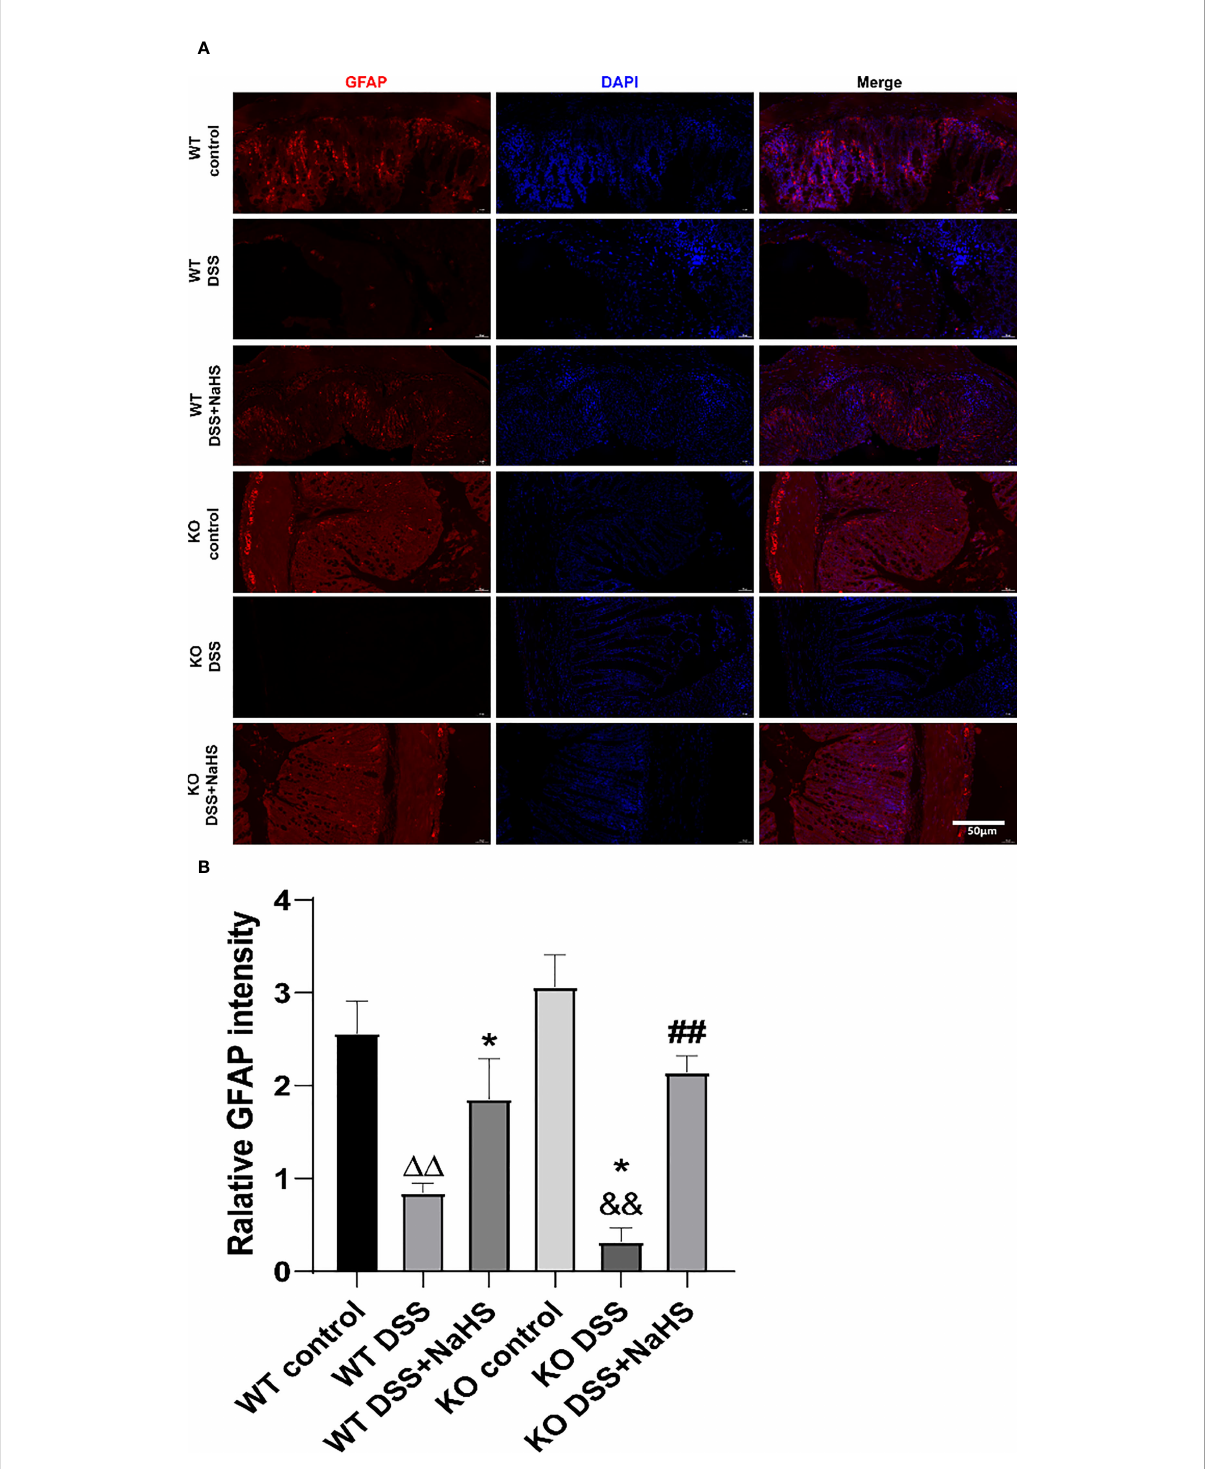
FIGURE 4 Effect of cystathionine- g -lyase (CSE)-produced hydrogen sul fi de (H 2 S) on the reactive astrocytes proliferation in colon of mice after dextran sodium sulfate (DSS) (mean±SEM, N=3). Scale bar=50 m m. (A) glial fi brillary acidic protein (GFAP)-positive cells are red, 4 ’ ,6-diamidino-2- phenylindole (DAPI) nuclear staining is blue (200×magni fi cation). (B) Relative GFAP intensity in the colon of mice. DD P<0.01 vs wild-type(WT) control group; *P<0.05 vs WT DSS group; && P<0.01 vs knockout(KO) control group; ## P<0.01 vs KO DSS group